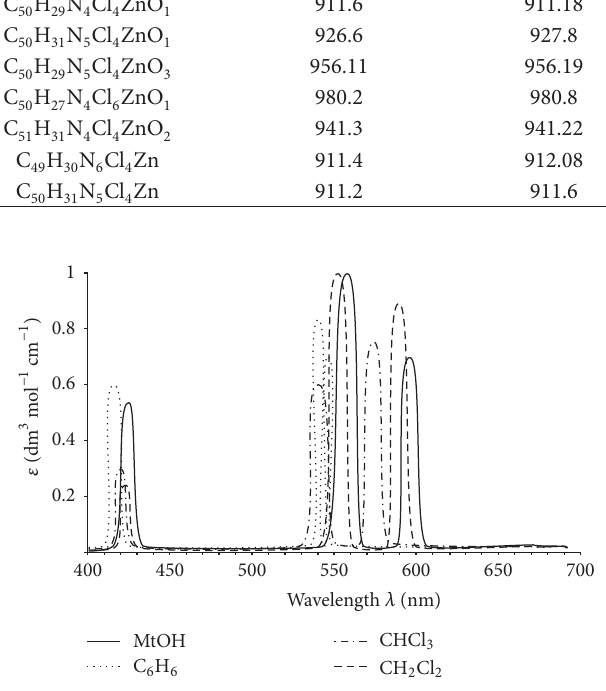
m/z ratio Observed Calculated